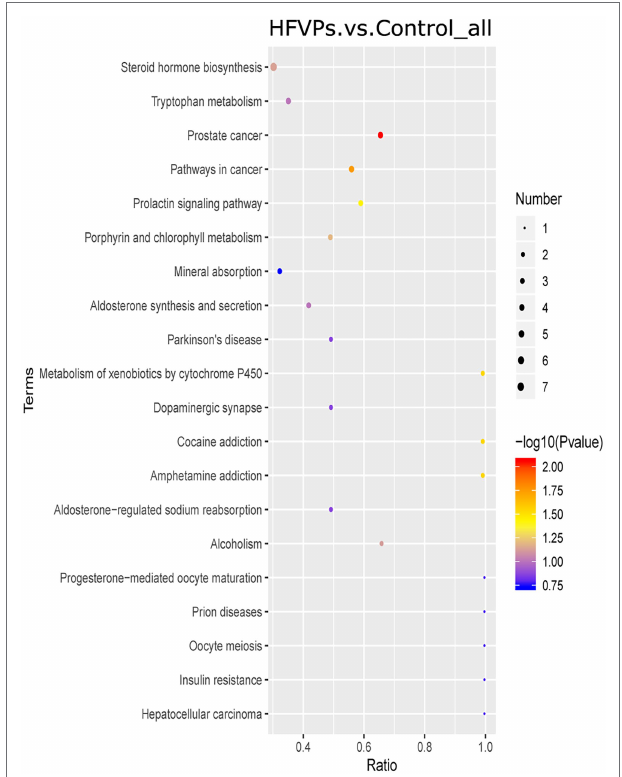
FIGURE 8 | Kyoto Encyclopedia of Genes and Genomes (KEGG) pathway enrichment plot of the significantly changed metabolites in the Control and HFVPs